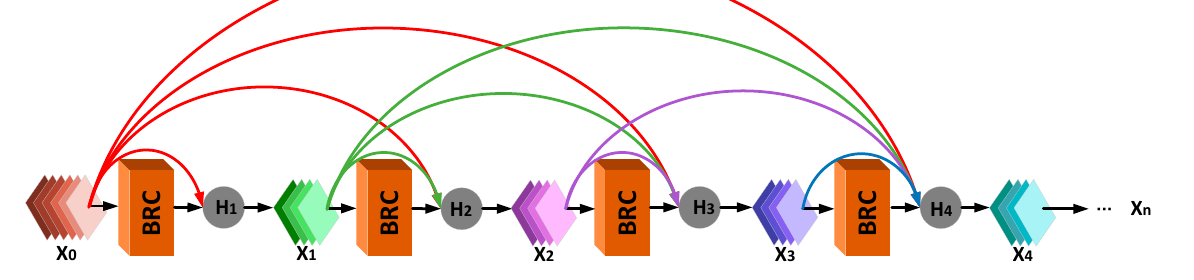
Figure 6. Dense-Block structure.